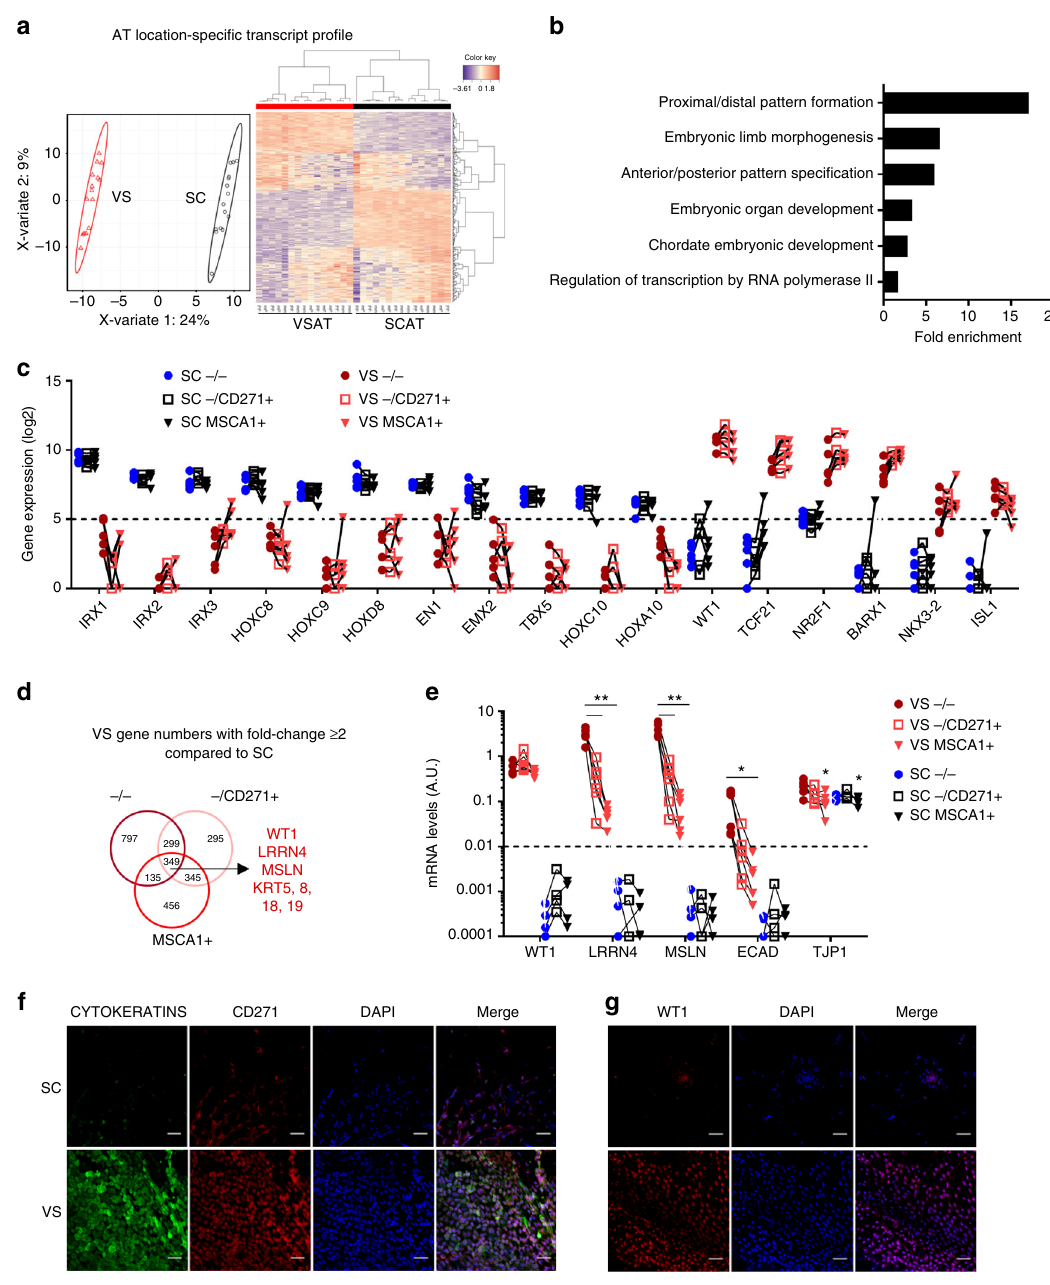
Fig. 6 Mesothelial-like nature of VSAT progenitor subsets. RNAseq analysis was performed on paired progenitor subsets isolated from VS and SCAT of fi ve obese donors. a Sparse partial least-square discrimant analysis plot of the two principal components. The 95% con fi dence ellipses are shown to strengthen the cell population clustering (left) and heatmap (right) of the top 300 most differentially expressed genes de fi ning AT location-speci fi c pro fi le (visceral VS red, subcutaneous SC black). Color code is set up according to gene expression (high expression in red, low in blue). b Gene Ontology pathways obtained from 300 most differentially expressed genes de fi ning AT location-speci fi c pro fi le independently of the progenitor subset. c Gene expression levels of SC and VSAT location-speci fi c transcripts in progenitor subsets isolated from SC and VSAT determined from RNAseq analyses. The results are expressed as log2 gene expression, n = 5 independent donors. d Venn diagrams of differentially expressed genes (fold change ≥ 2 from a raw P -value) in each VS progenitor subset compared with SC subsets, highlighting some genes of interest. e mRNA levels of mesothelial markers ( WT1 , LRRN4 , and MSLN ) and epithelial markers ( ECAD , TJP1 ) in native cell subsets sorted from VS ( n = 6) and SC ( n = 4) AT measured by RT-qPCR. Two-way ANOVA followed by Tukey ’ s multiple comparison test, * P < 0.05, ** P < 0.01. f Representative images of CYTOKERATINS (green) and CD271 (red) immunostainings on the SC and VS lobule septa ( n = 3). Nuclei are stained with DAPI (blue). Scale bars: 100 µ m. g Representative images of WT1 (red) immunostainings on SC and VS lobule septa ( n = 3). Nuclei are stained with DAPI (blue). Scale bars: 100 µ